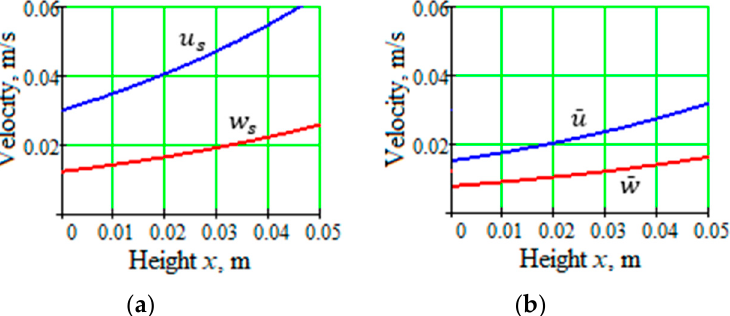
Figure 3. The components of the film flow velocity on the interfacial surface ( a ) and the average film flow velocity ( b ).